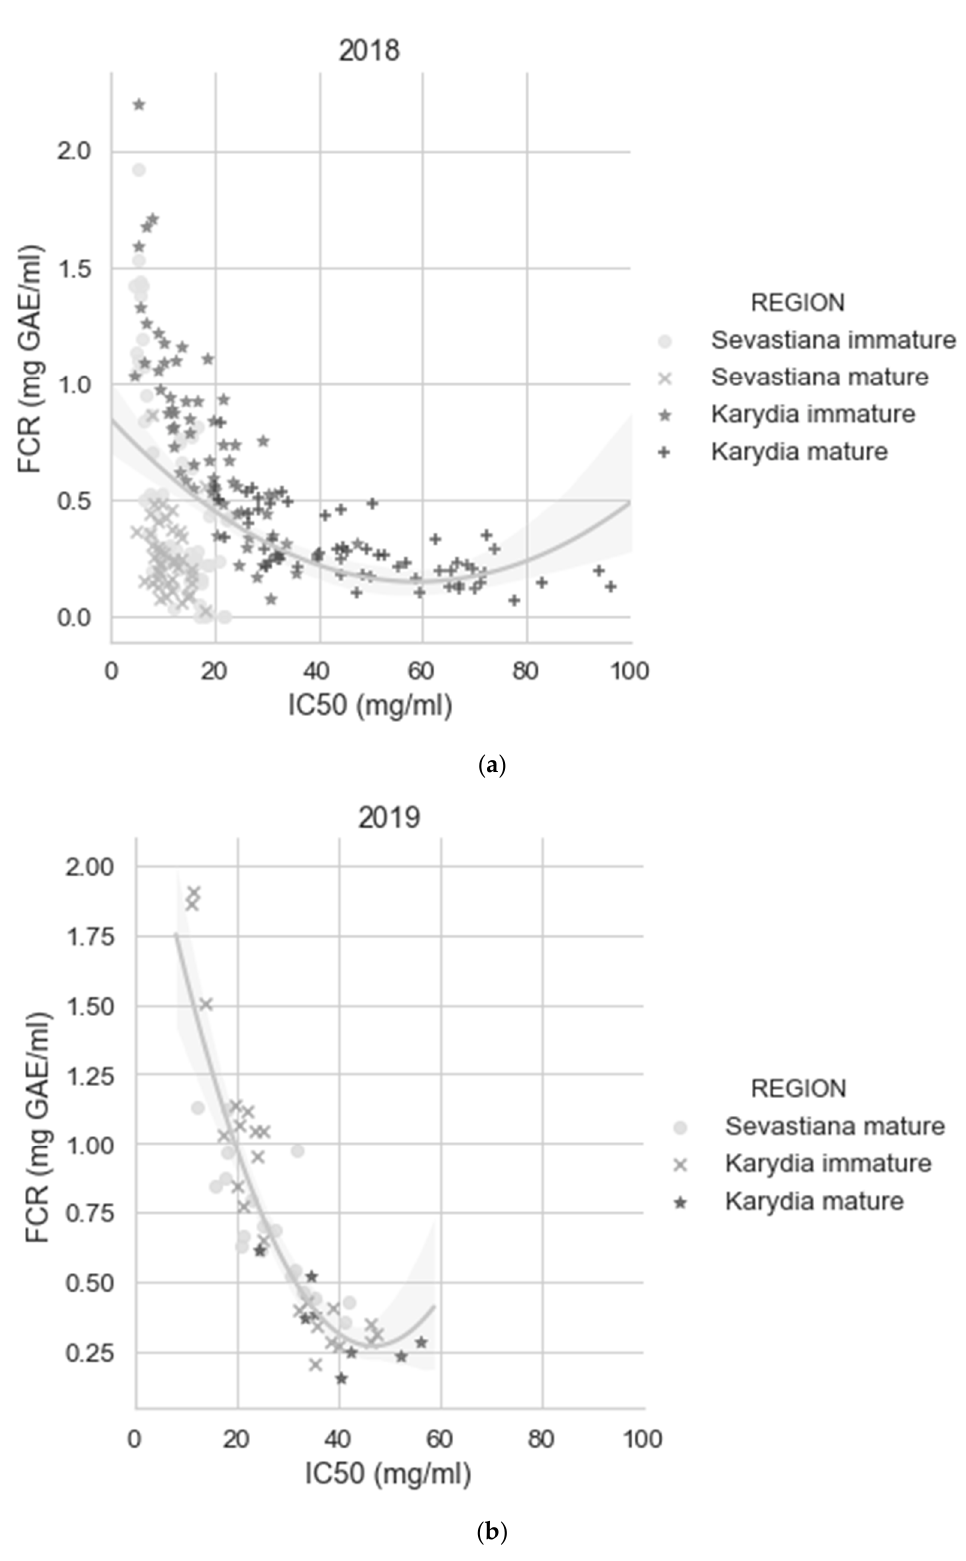
Figure 6. Relationships between DPPH and FCR for ( a ) 2018 ( R 2 = 0.21) and ( b ) 2019 ( R 2 = 0.81). Both graphs show that mature cherry fruits harvested at Karydia had higher than 20 mg/mL IC50 values for both 2018 and 2019.